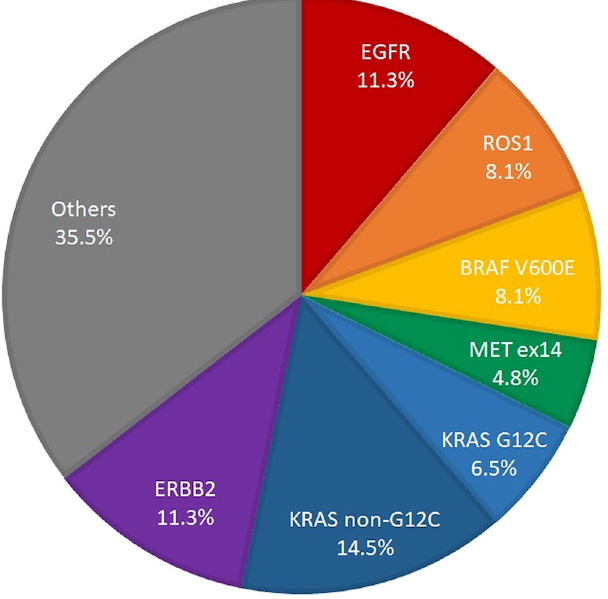
Figure 1. Driver mutations detected by NGS in the cobas EGFR wild type cohort (n =